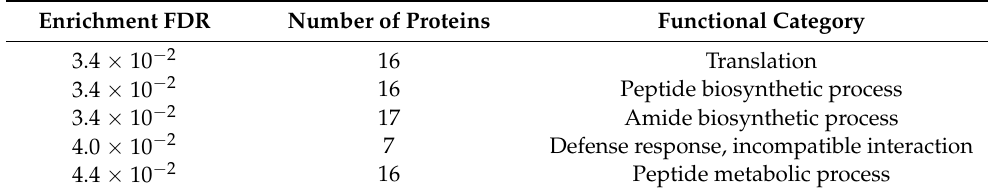
Table 1. GO enrichment analysis of highly up-regulated Arabidopsis proteins specifically in the epidermis at 4